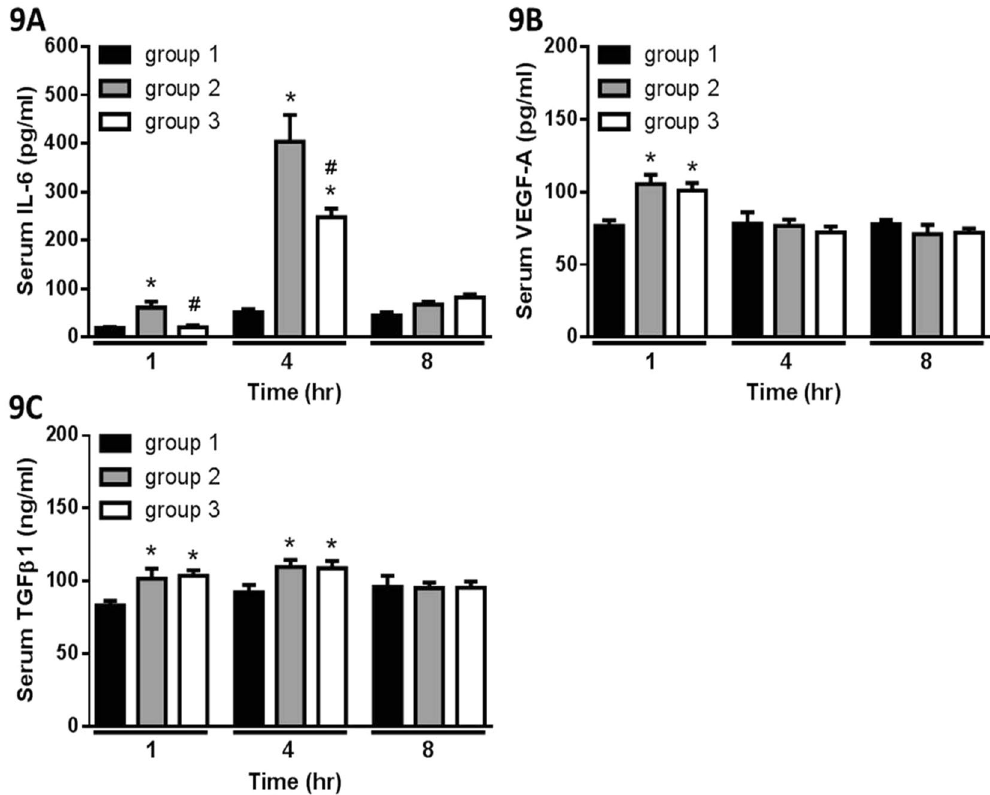
Figure 9. The changes of serum cytokines in the post-surgical adhesion mouse model. The levels of mouse serum ( A ) IL-6, ( B ) VEGF-A and ( C ) TGF β 1 at 1, 4 and 8 hr after the operation are presented. * P < 0.05 vs. Group 1; # P < 0.05 vs. Group 2. Group 1, n = 6; Group 2, n = 10; Group 3, n =